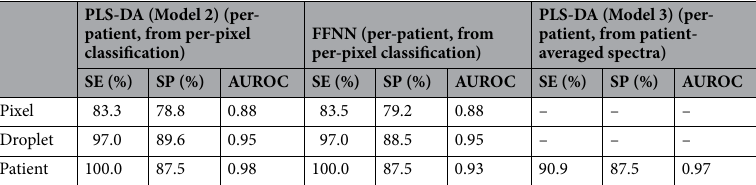
Table 3. Experiment 2: Values of sensitivity (SE), specificity (SP) and area under the receiving operating characteristic (AUROC) curve obtained at per-patient classification from both types of analysis, partial least